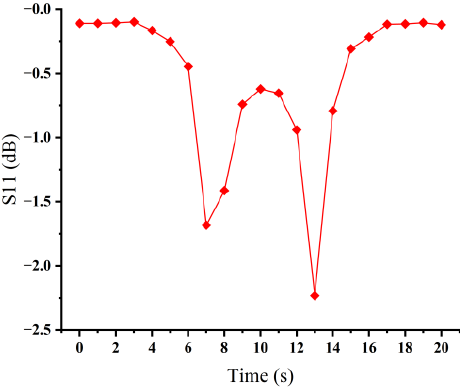
Figure 12. Port reflection coefficient at different times. (Cavity height:180 mm).